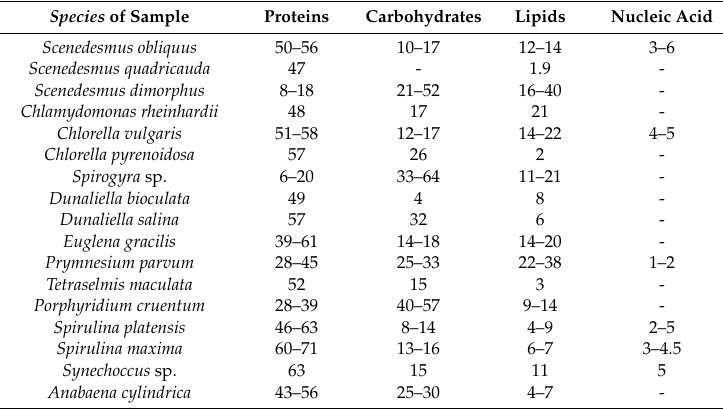
Table 2. Chemical composition of algae on a dry matter basis (%)